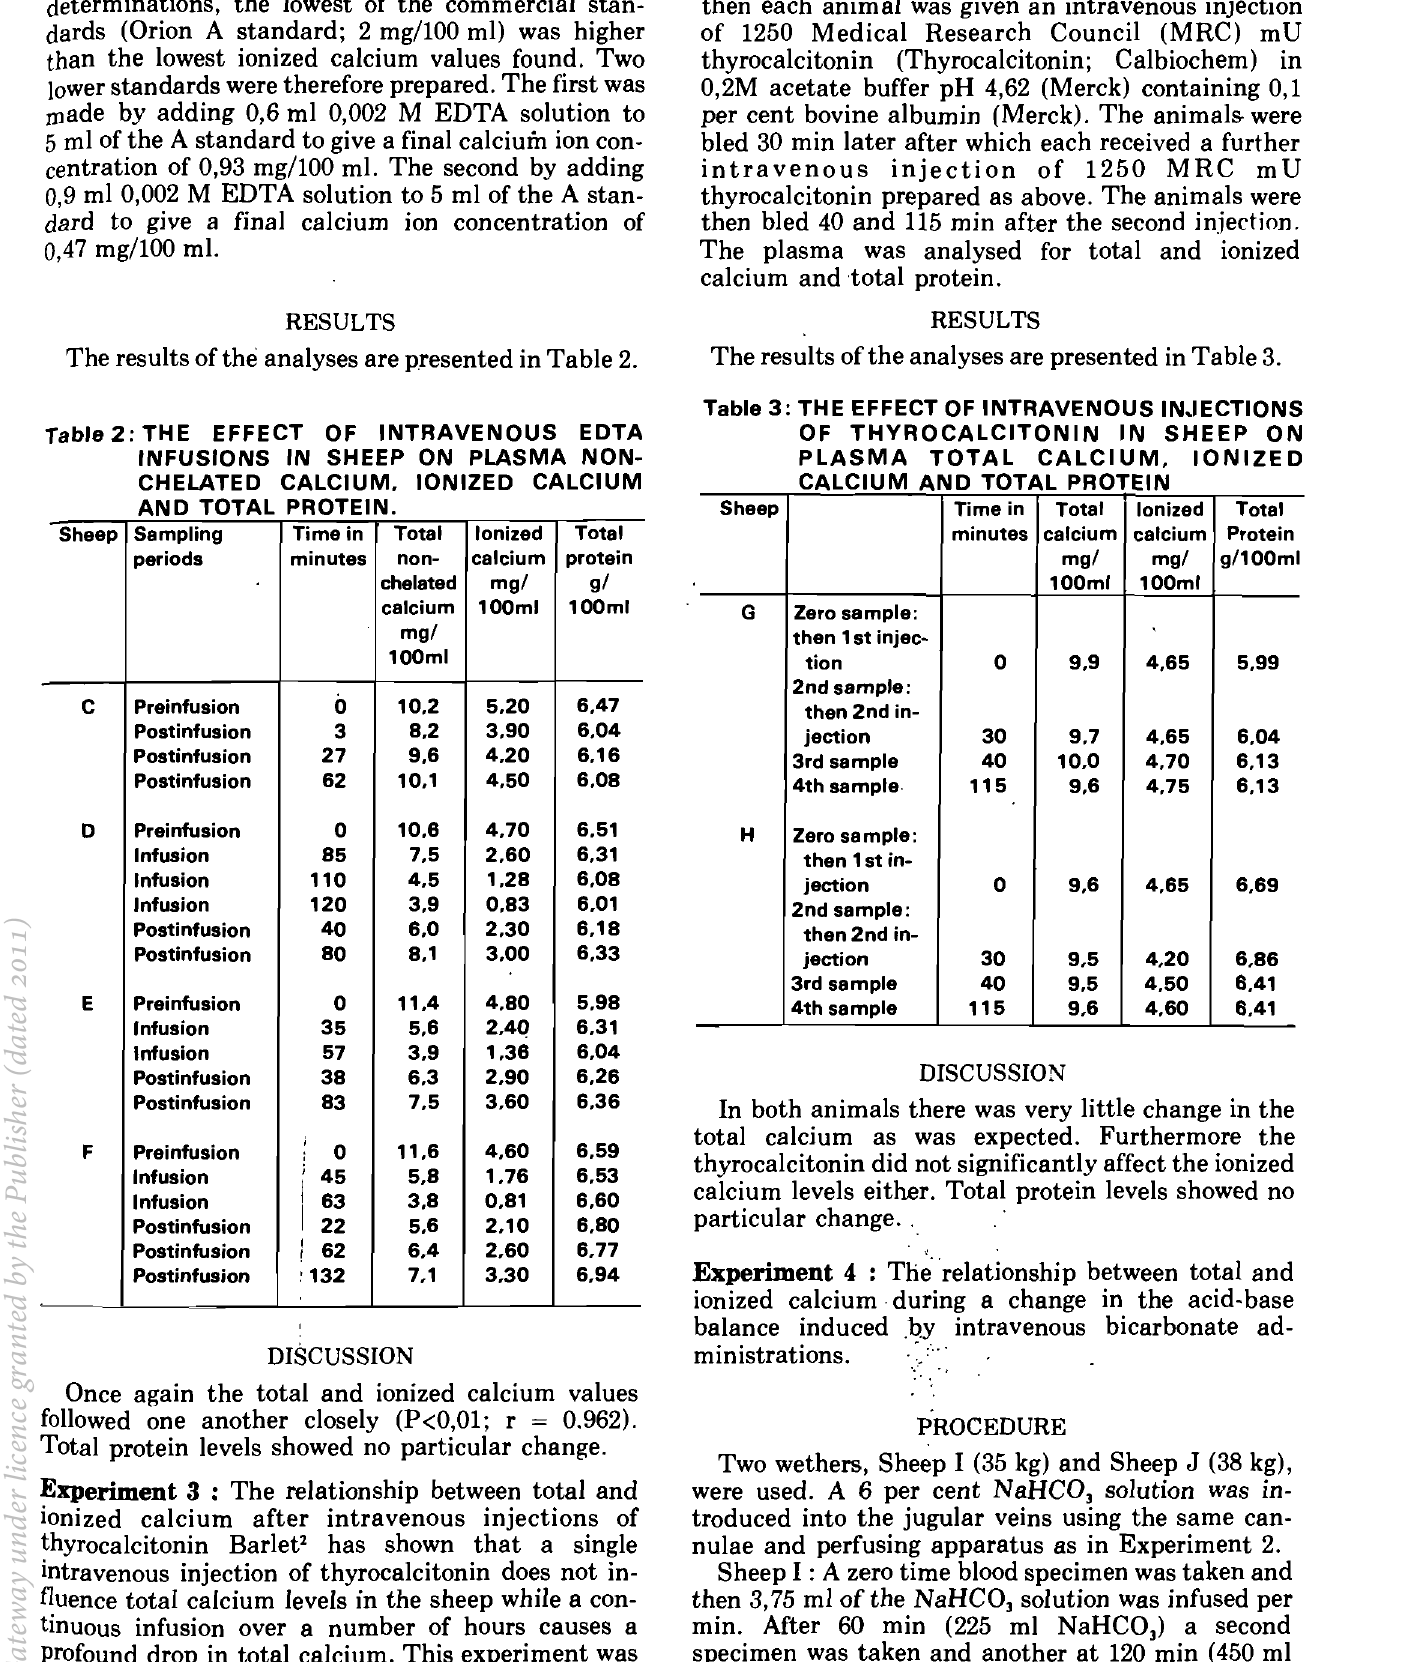
Table 3: THE EFFECT OF INTRAVENOUS IN.IECTIONS OF THYROCALCITONIN IN SHEEP ON PLASMA TOTAL